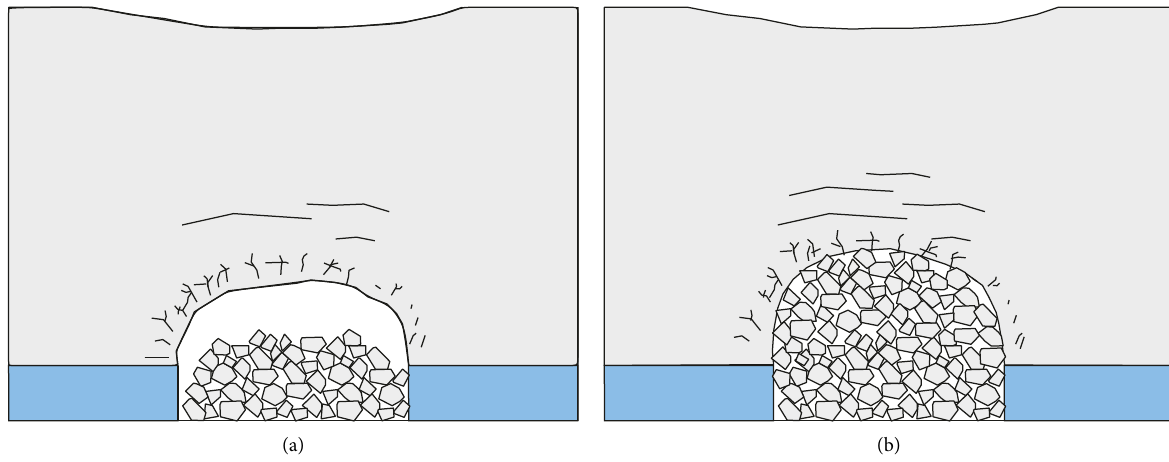
Figure 9: The process of arched caving in the roof strata. (a) Initial caving of the roof strata. (b) Natural termination of rock strata